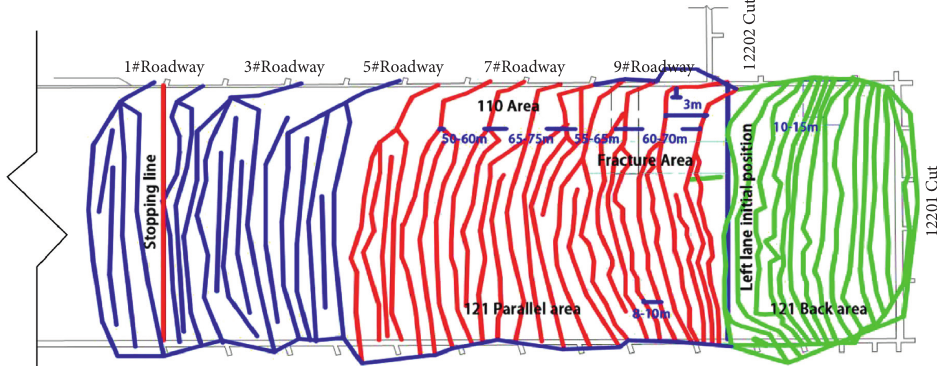
Figure 12: Surface fracture development zone comparison.